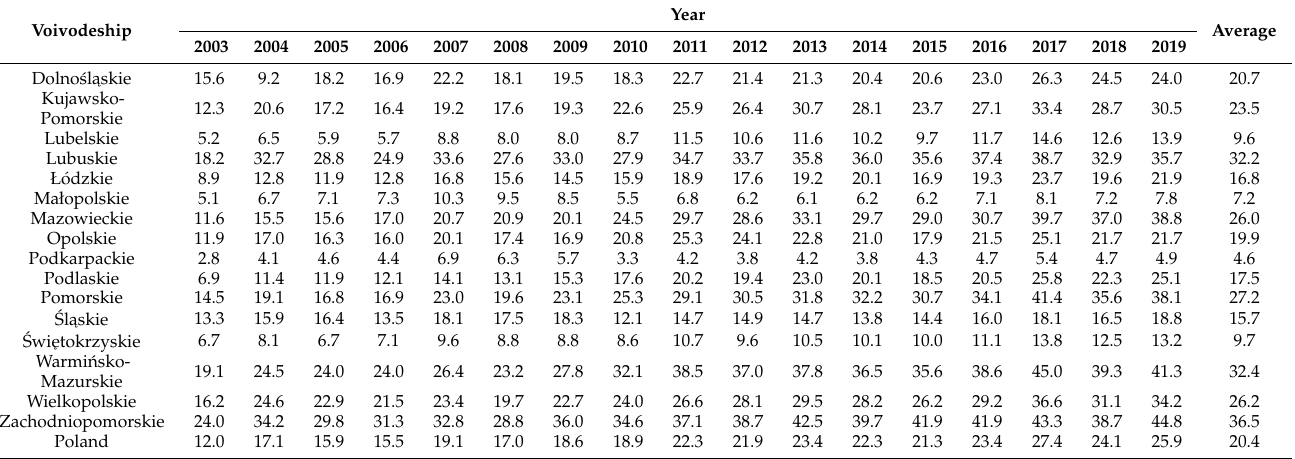
Table 1. Gross value added per person employed in PLN thousand/person in 2003–2019 1